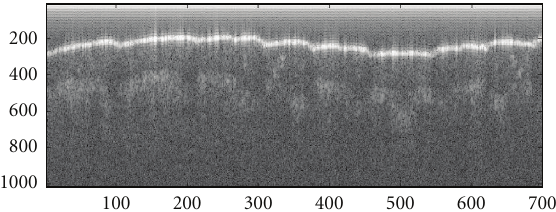
Figure 9: OCT image reconstructed from integrated